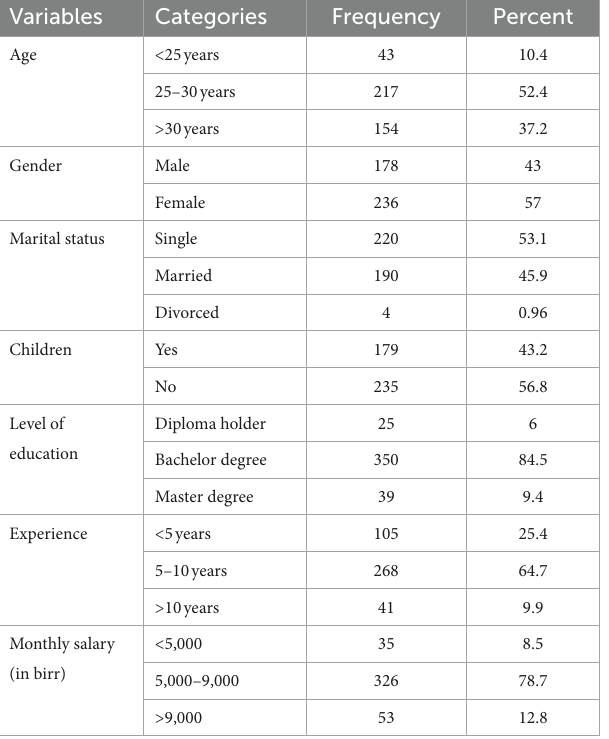
TABLE 1 Socio-demographic characteristics of nurses working at public hospitals of Addis Ababa, Ethiopia, 2022 ( N =